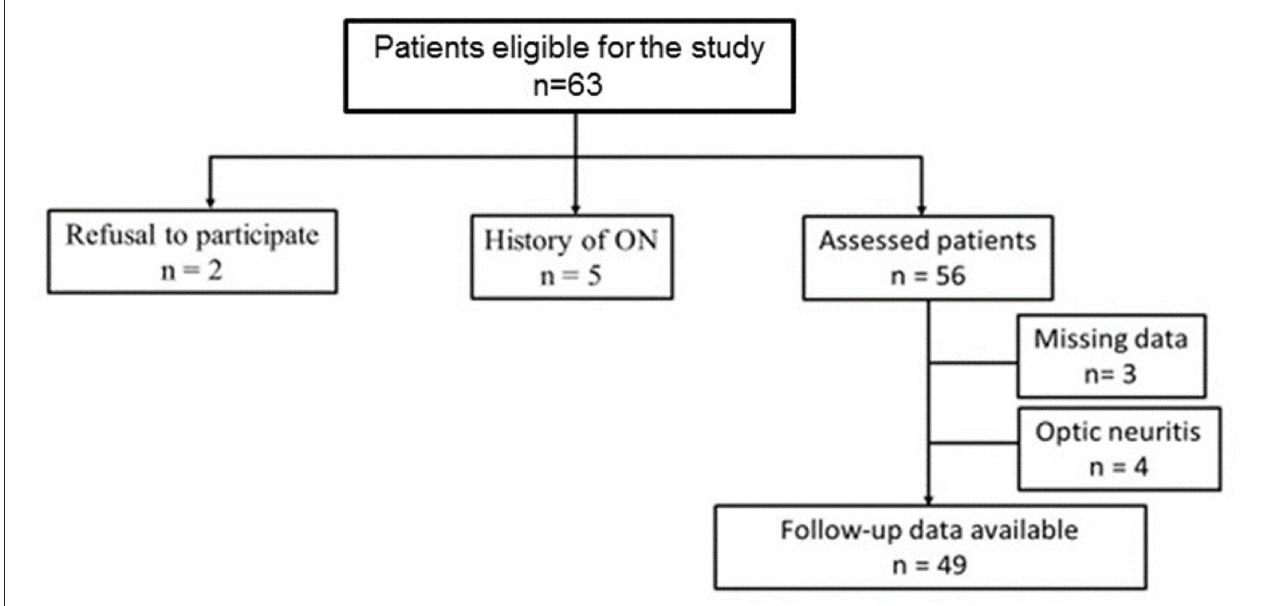
FIGURE 1 | Flowchart illustrating patient selection. ON, optic